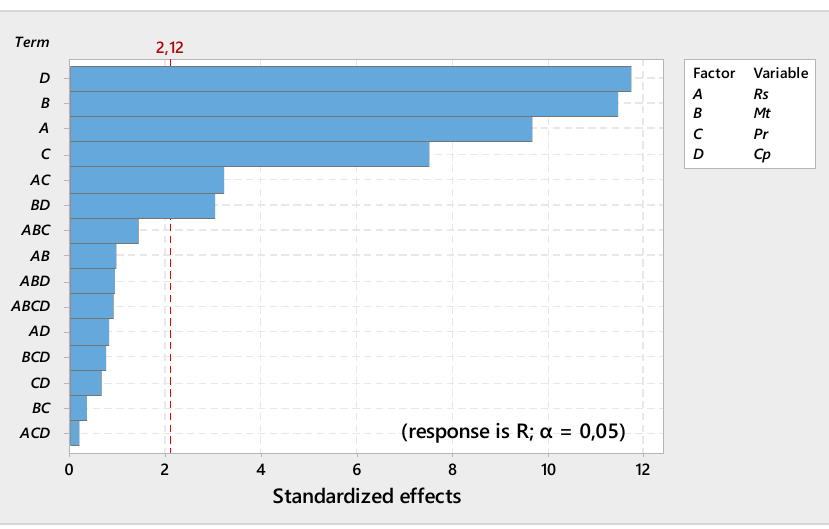
Figure 3. Pareto graph analysis for the factorial experiment with 4 levels.